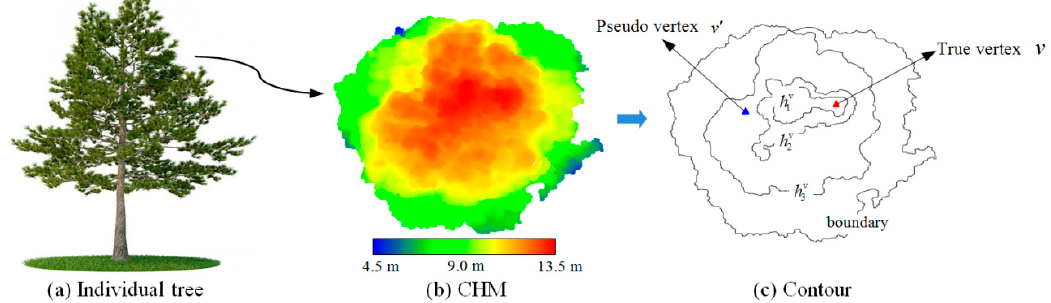
Figure 8. Contour-surround constraint for pseudo vertex removal. ( a — c ) correspond to an individual tree, the CHM of the individual tree, and the contour of the CHM. Red and blue triangles denote true and pseudo vertices, respectively. CHMs: canopy height